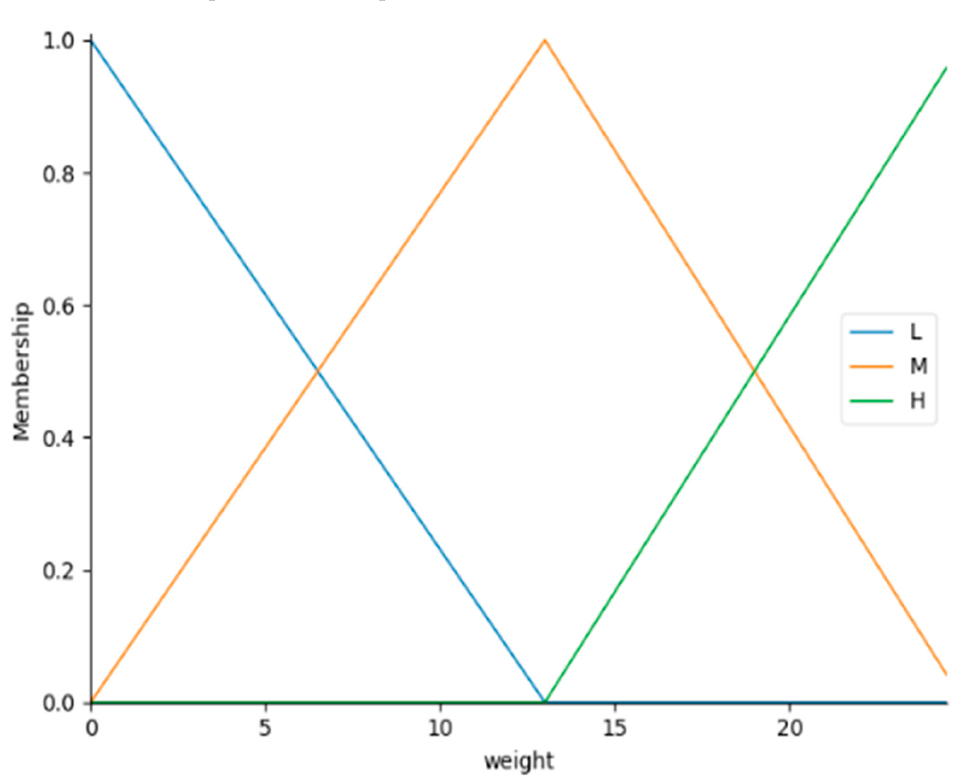
Figure 10. Membership function of electronic belt scale weight.